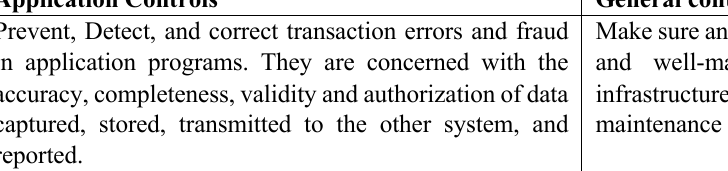
Table 2. Dynamic Marketing Capabilities of Internal Control